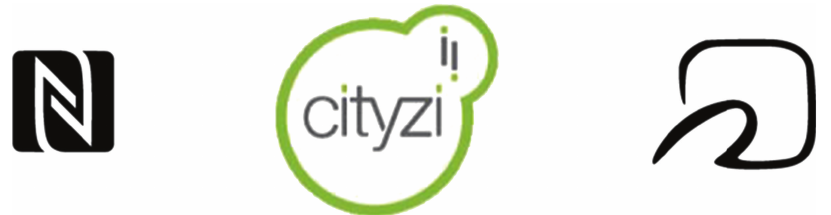
Figure 2: Symbols for advertising NFC tags.